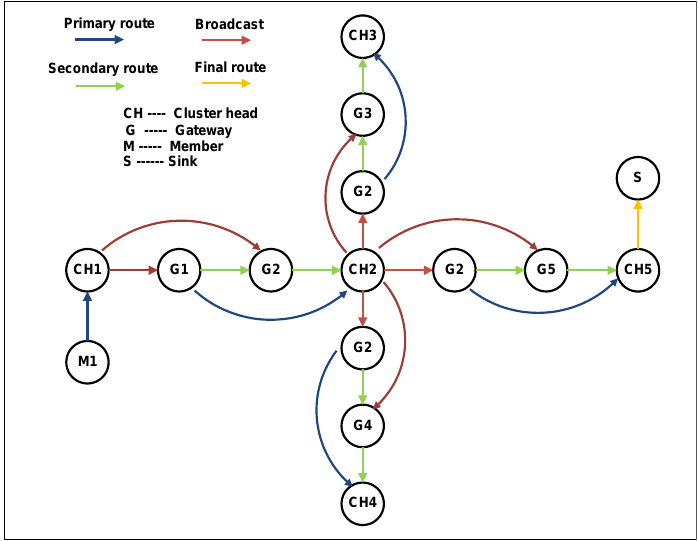
Figure 3. Routing Strategy for hierarchical